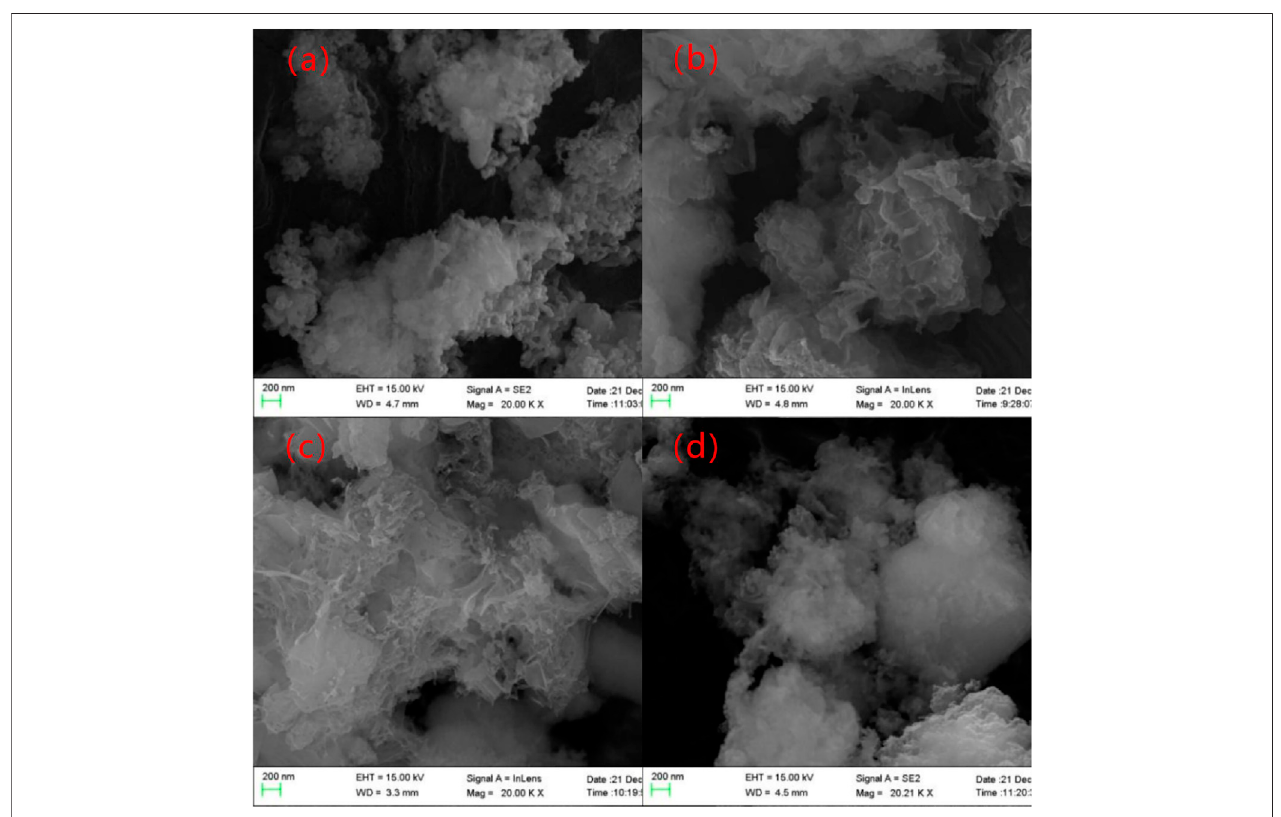
FIGURE 2 | SEM patterns of different autoclave (A and B) and calcining (C and D) materials.